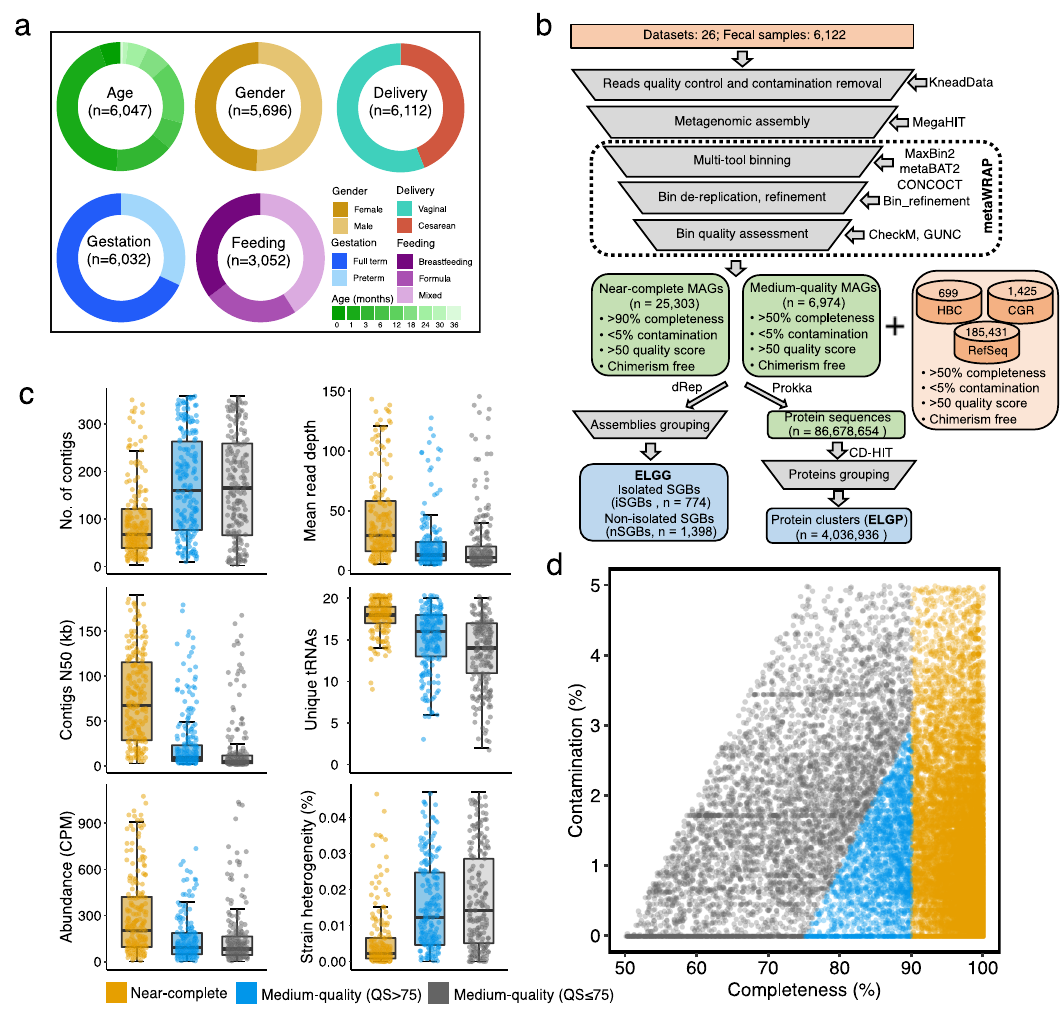
Fig. 1 | The reconstruction of sequence catalog from the early-life human gut microbiome. a The number and proportion of fecal metagenomes strati fi ed by clinicalfeaturesincludingage,gender,deliverymode,gestationalage, and feeding patterns. b Overview of the computational pipeline to generate ELGG and ELGP catalogs. c Quality metricsacrossnear-complete ( n =25,303), medium with quality